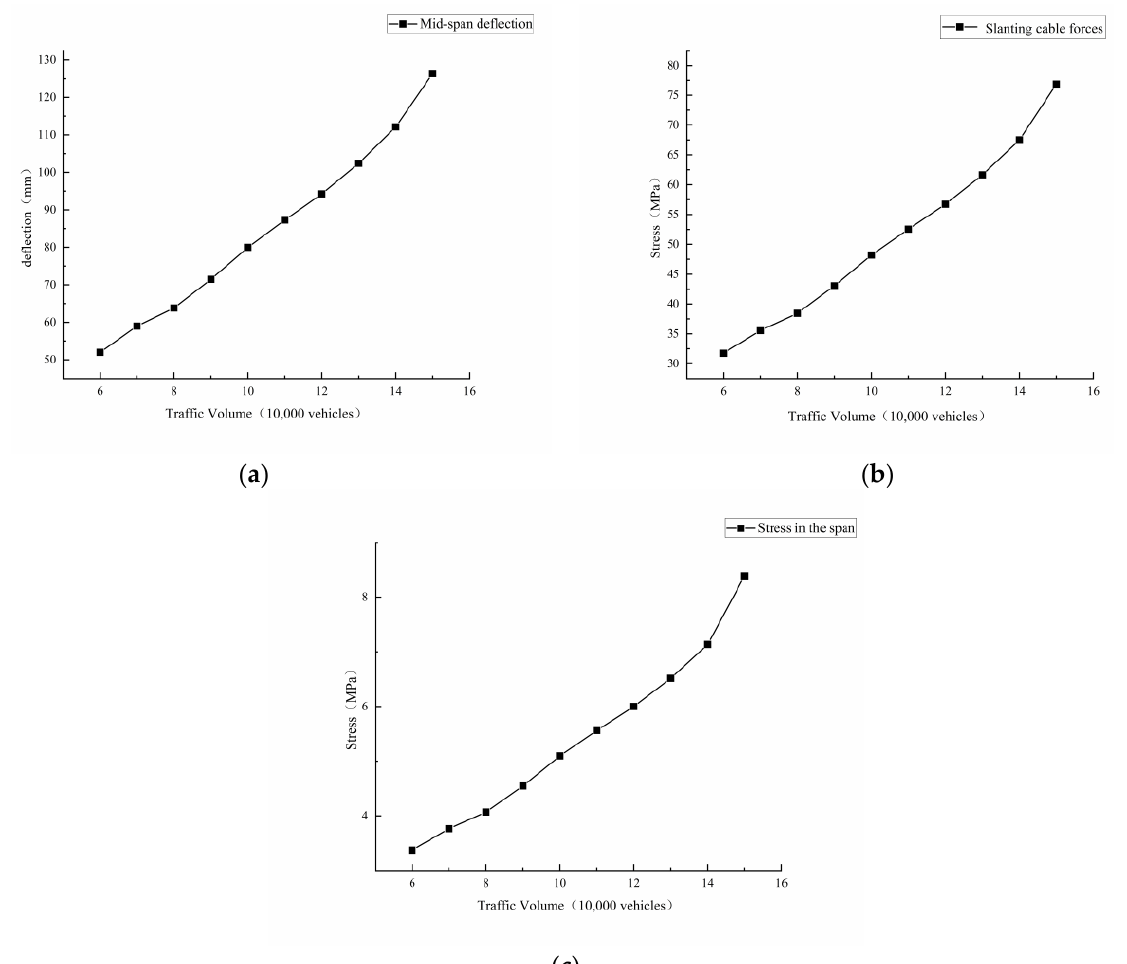
Figure 8. The structural state changes under various working conditions: ( a ) the variation of deflection in span, ( b ) the stress variation diagram of No.1133 diagonal cable, ( c ) the stress variation diagram of span-middle beam unit.